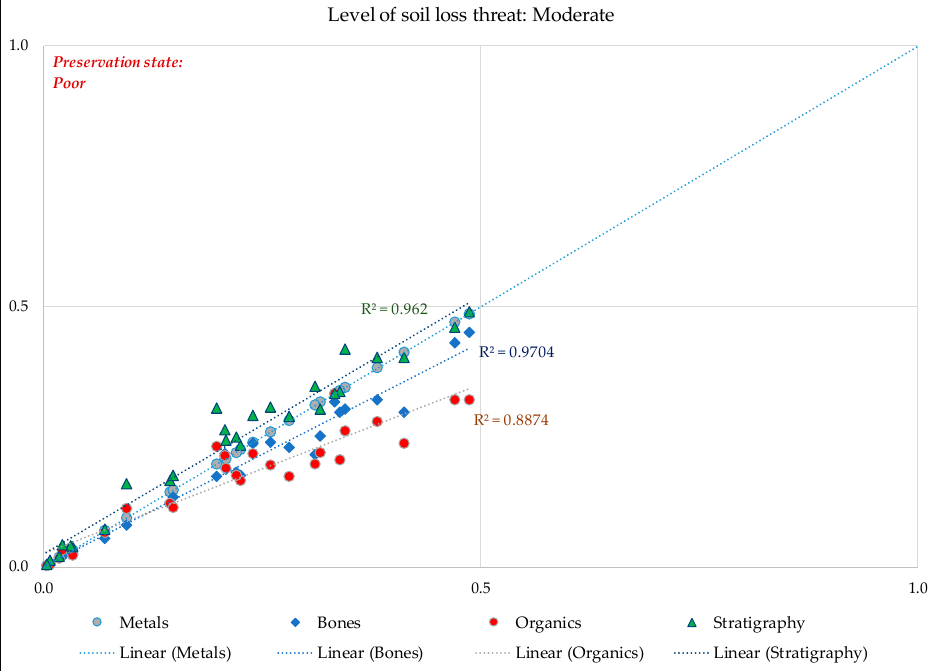
Figure 12. Correlation of the different types of subsurface objects (metals, bones, organics, and stratigraphy) between areas characterized as moderate for soil-loss threat: Metals objects were used as the baseline (R = 1). Preservation state is also indicated for areas with di ff erent colours (same as Figure 11. Note here that only poor preservation state is